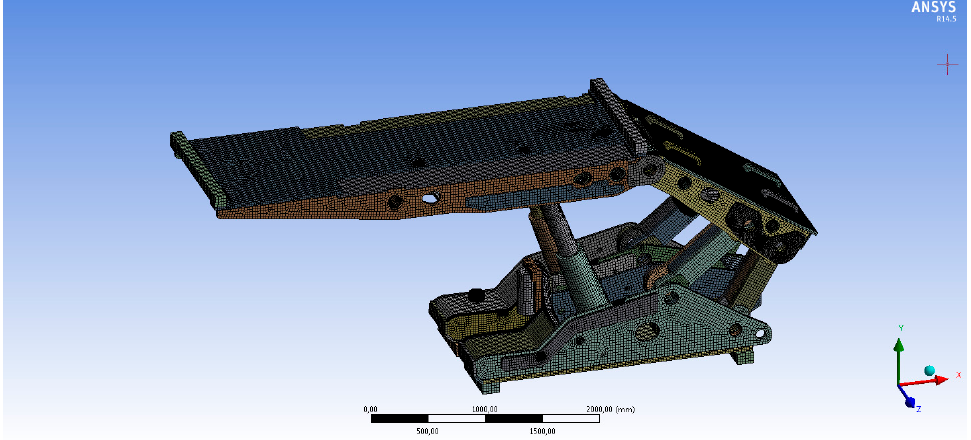
Figure 4. The 3D model of the support section with a numerical grid.